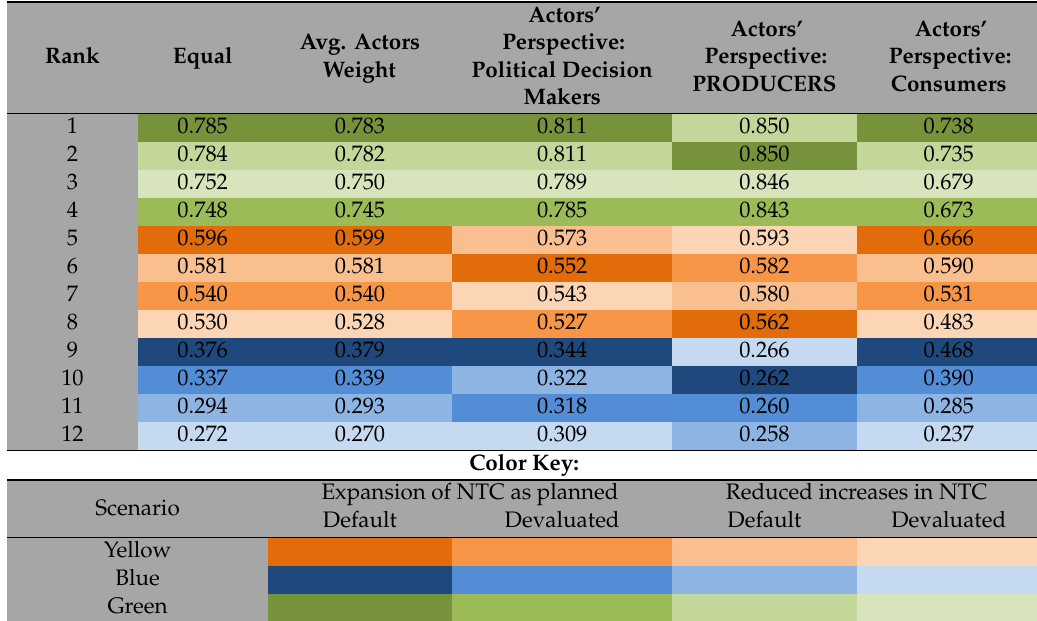
Table 9. TOPSIS analysis of modeling results. Source: Own